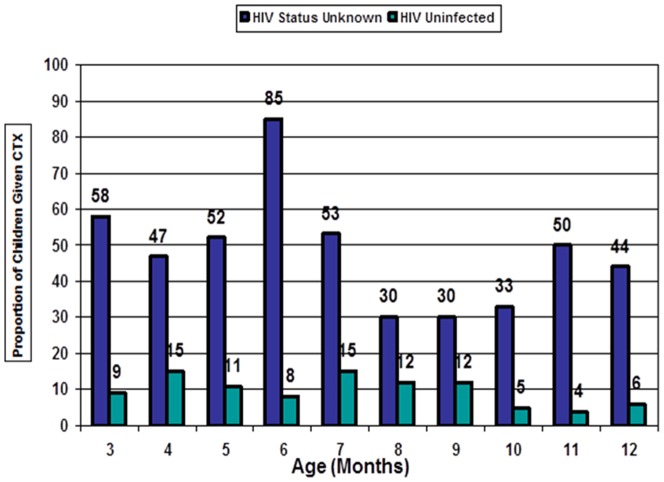
Coverage of cotrimoxazole prophylaxis in infants in association with HIV infection status.In this predominantly non-breastfed population, infants in the various age categories were still receiving cotrimoxazole prophylaxis despite their known “HIV-Uninfected Status” as represented by the green column. A larger proportion of infants were also continuing cotrimoxazole prophylaxis across the increasing age categories, due to their “Unknown HIV Status” as represented by the blue column.